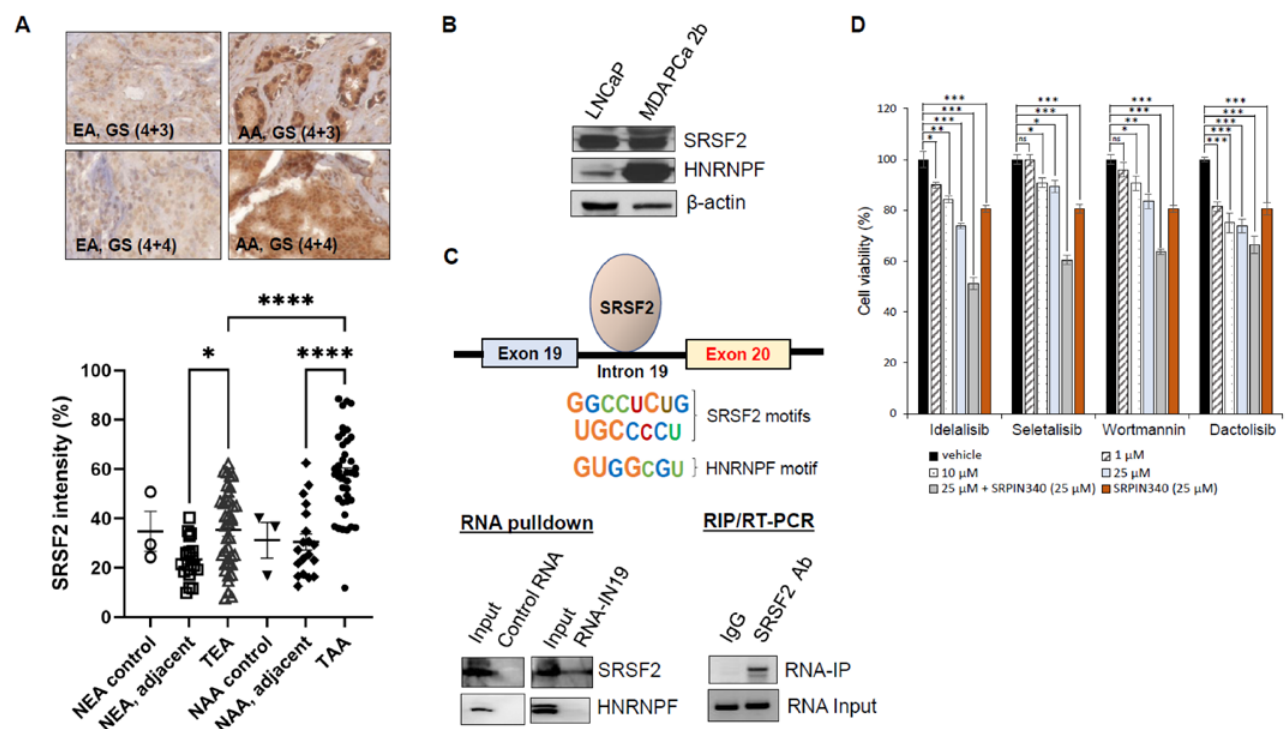
Figure 6. SRSF2 mediates skipping of exon 20 in PIK3CD pre-mRNA, and inhibition of SRPK1/2 sensitizes PIK3CD-S -expressing PCa to Idelalisib, Seletalisib, Wortmannin, and Dactolisib. ( A ) IHC staining of SRSF2 on a TMA containing 40–50 EA and AA PCa specimens. Representative IHC images of SRSF2 staining in EA and AA PCa with GS (4 + 3) and GS (4 + 4) are presented (top panel). Quantification of SRSF2 intensities in samples derived from NEA, NEA adjacent, TAA, NAA, NAA, NAA adjacent, and TAA. p -values (* <0.05, **** <0.0001) were determined based on one-way ANOVA with Tukey’s post hoc test. ( B ) Western blot analysis revealed that SRSF2 and HNRNPF were upregulated in MDA PCa 2b (AA PCa) vs. LNCaP (EA PCa) cells. ( C ) RNA pulldown and RIP/RT-PCR assays revealed that SRSF2 is the critical RNA-binding protein at the flanking intron adjacent to exon 20 of PIK3CD pre-mRNA. Two major SRSF2 and one HNRNPF putative binding motifs located in intron 19 were highlighted (top panel). Representative Western blot and gel images from RNA pulldown and RIP/RT-PCR assays were presented to confirm the SRSF2 binding at RNA fragment of flanking intron (RNA-IN19) covering the 2 SRSF2 and 1 HNRNPF motifs. ( D ) MTT assays for PIK3CD-S -expressing MDA PCa 2b in the presence of vehicle, small-molecule inhibitors (at 1, 10, and 25 µ M), SRPIN340 (25 µ M), and combination therapy (25 µ M small-molecule inhibitor and 25 µ M SRPIN340). p -values (* <0.05, ** <0.01, *** <0.001) were determined based on one-way ANOVA with Tukey’s post hoc test. ns: not significant. Data values represent mean ± SD from 4–5 independent